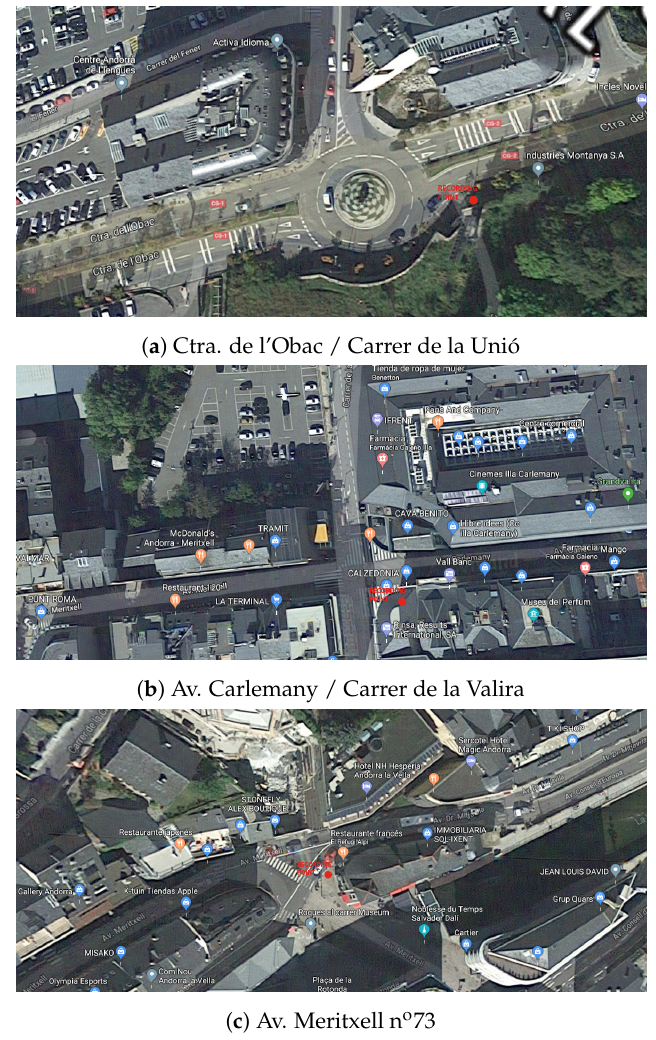
Figure 1. The three places where the recordings took place from a satellite perspective using Google Maps. The red dot in each picture indicates the place where the recordings were